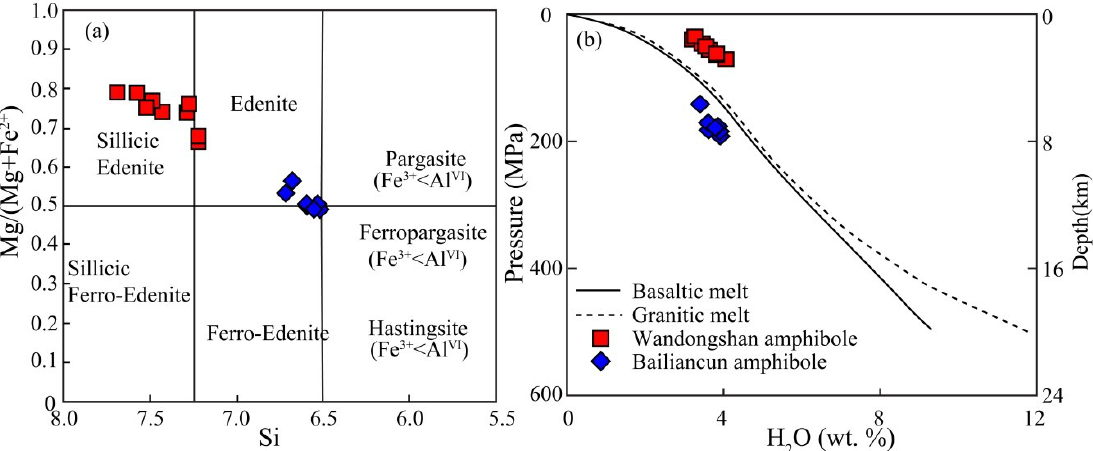
Figure 4. Composition of amphiboles from the Wandongshan and Bailiancun monzogranite porphyries, using the nomenclature of Leake et al. [42] ( a ), and experimentally determined solubilities of H 2 O in silicate melts as a function of granitic pegmatite pressure ( b ) [44]. WDS: Wandongshan; BLC: Bailiancun. Table 2. The water content and oxidation state of the parental magmas from the Wandongshan and Bailiancun